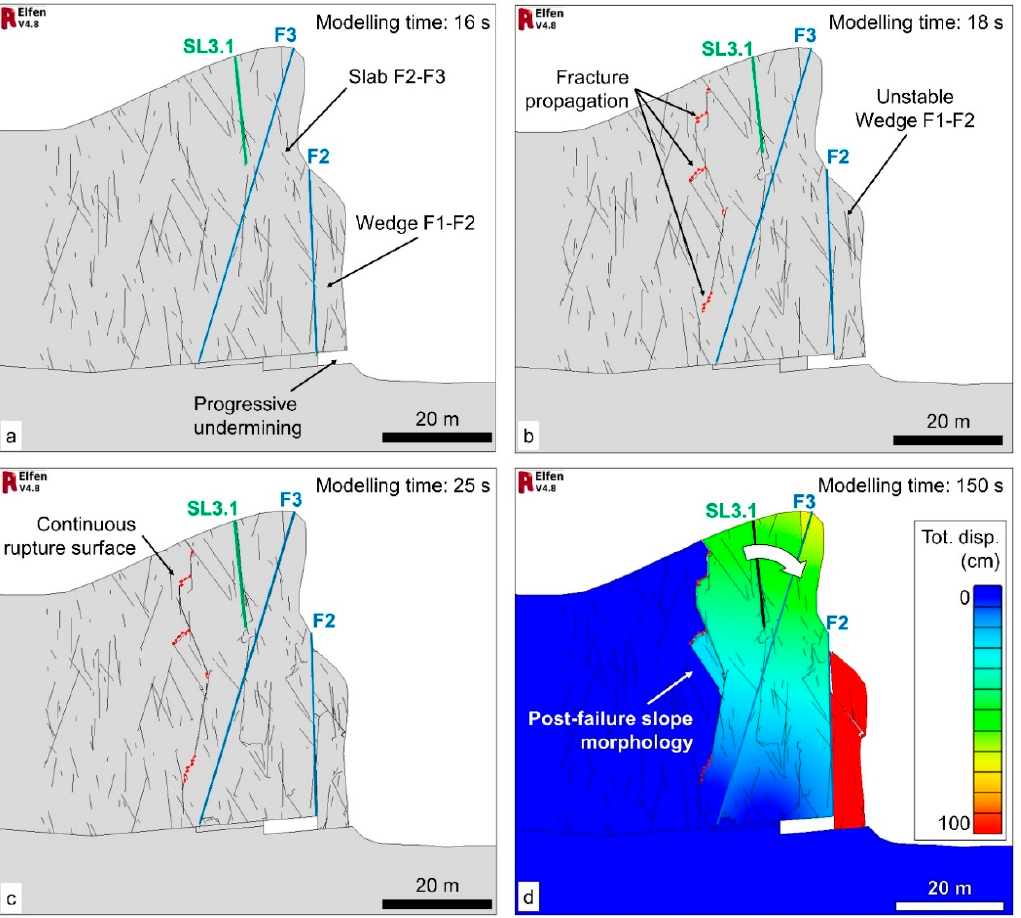
Figure 12. Overview of the San Leo landslide Model 2. ( a ) First undermining stage. No brittle damage is simulated; ( b ) Second undermining stage. Wedge F1–F2 is kinematically free, and displaces vertically. Fracture propagation occurs in the rock mass behind SL3.1; ( c ) Third undermining stage. Fracture propagation causes the formation of a continuous rupture surface. Brittle fracture propagation occurs in the undermined area; ( d ) Total displacement magnitude plot after 150 s (modelling time). Note that the toppling instability in model 2 involves a volume higher than that observed in situ.